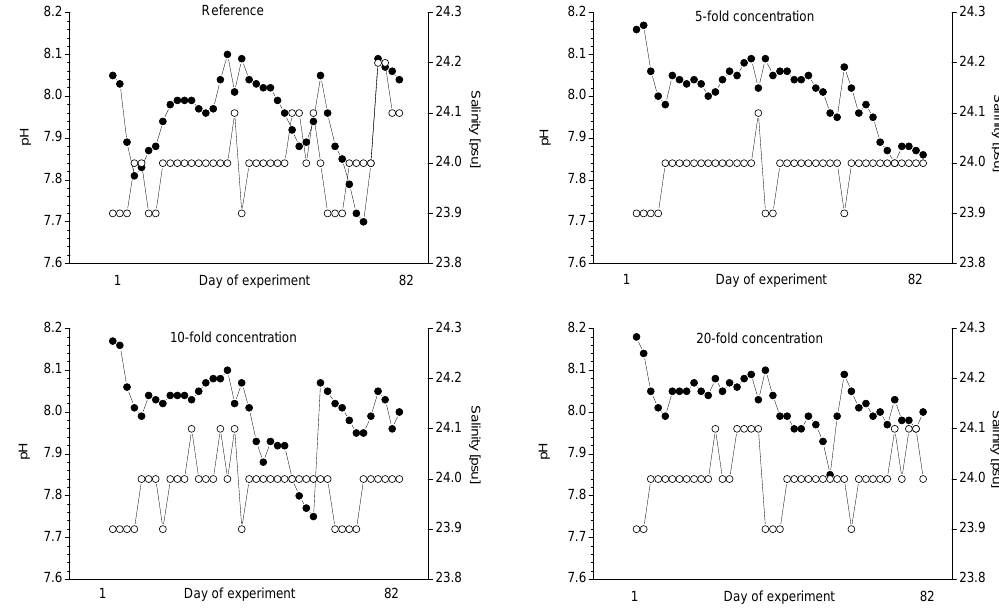
Fig. 3. Salinity [psu] ( ◦ ) and pH ( • ) monitoring of each culture solution throughout the 82 days of the experiment.